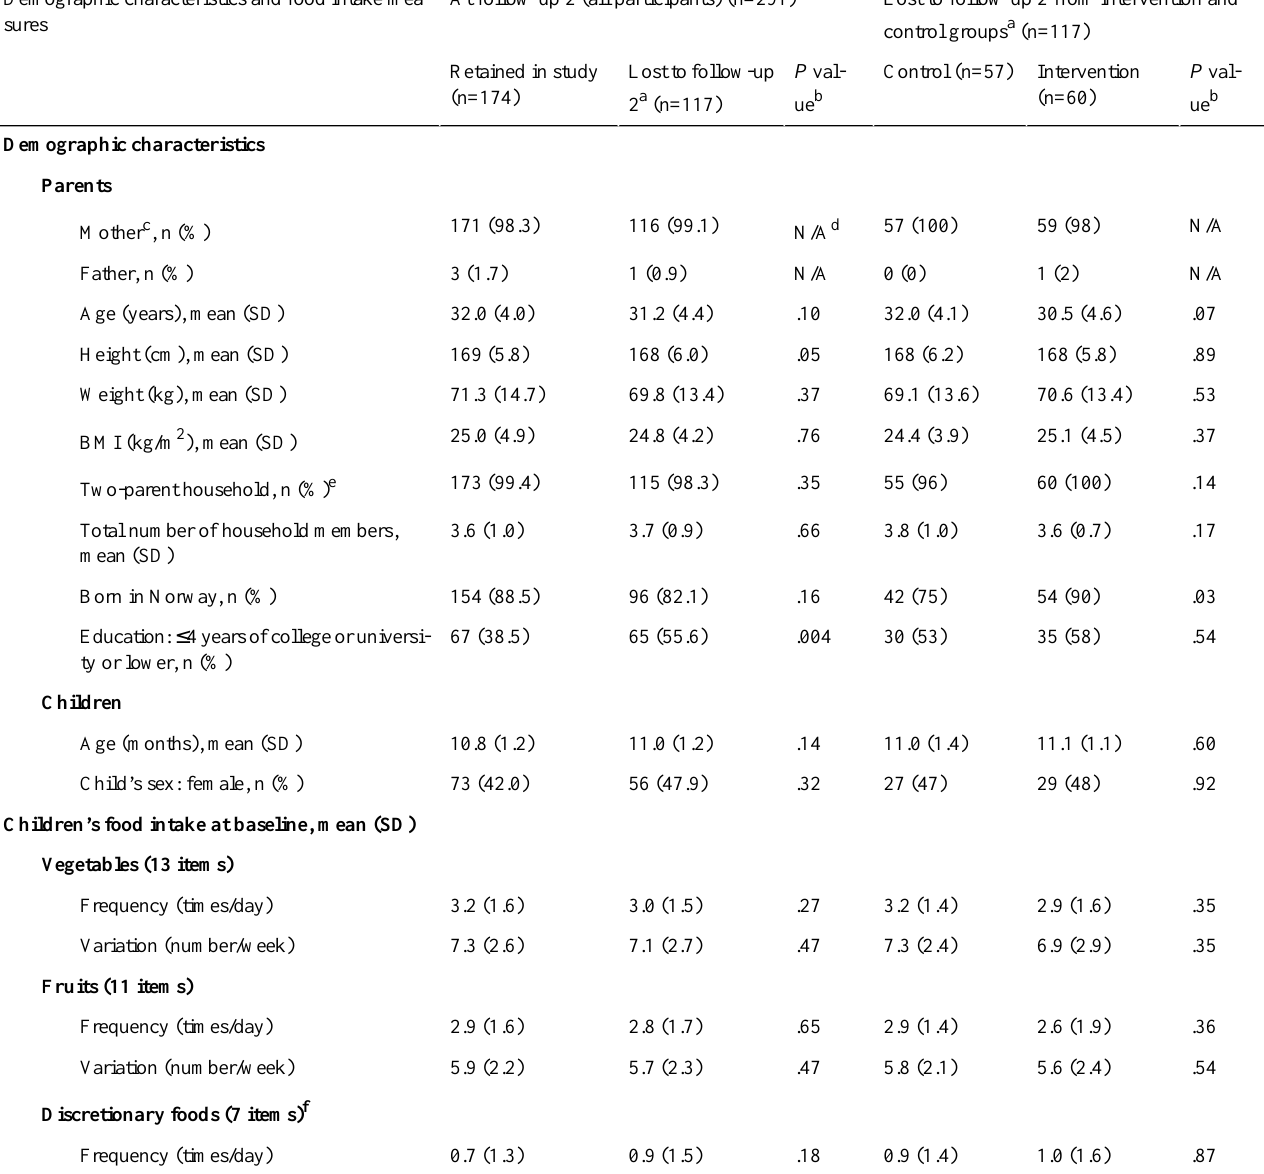
(n=117)At follow-up 2 (all participants) (n=291)Demographic characteristics and food intake